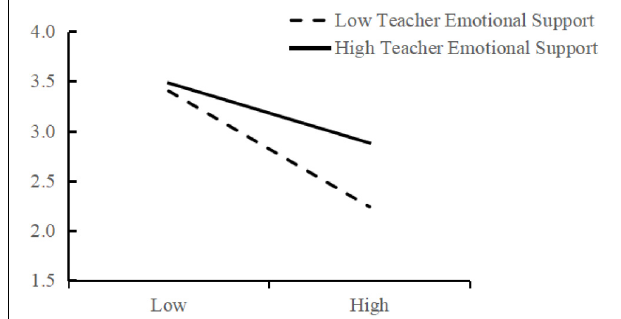
FIGURE 4 | Moderating effect of teacher emotional